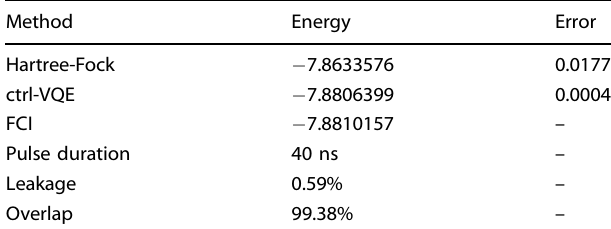
Table 1. Performance of ctrl-VQE in computing the ground state energy of the LiH molecule (Li – H R = 1.5 Å). The energy error relative to FCI, the leakage to higher energy states, the total pulse duration, and the overlap with the exact FCI state are shown. The data correspond to the pulse with fi ve time segments from Fig.